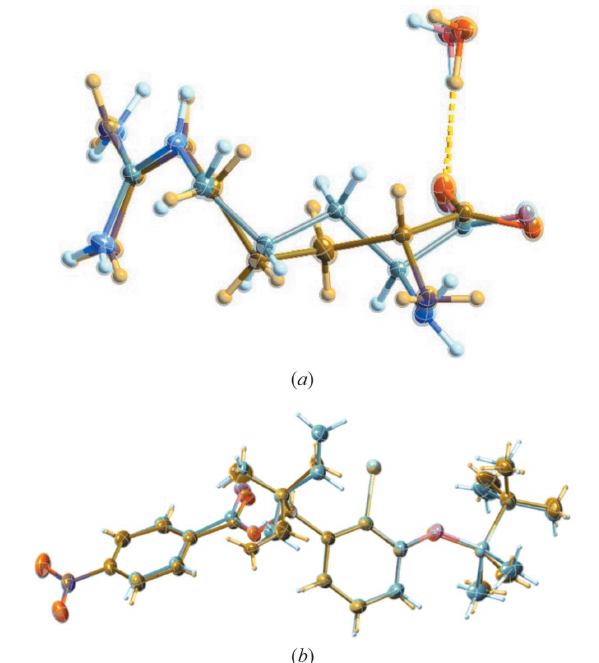
Figure 4 Displacement ellipsoid representations of the molecular structures of DL-arginine monohydrate [CSD refcode FUGXIO01, ( a )] and 1-(2- bromo-3-{[ tert -butyl(dimethyl)silyl]oxy} phenyl)-2,2-dimethylbut-3-en-1- yl 4-nitrobenzoate [CSD refcode IRUMAL, ( b )], highlighting the disordered parts of the different conformations of the molecules in the disordered structures. The illustrations were generated with SHELXLE (Hu¨bschle et al. , 2011) using the restrained (DFIX/DANG) and additionally constrained (EADP) refinements I